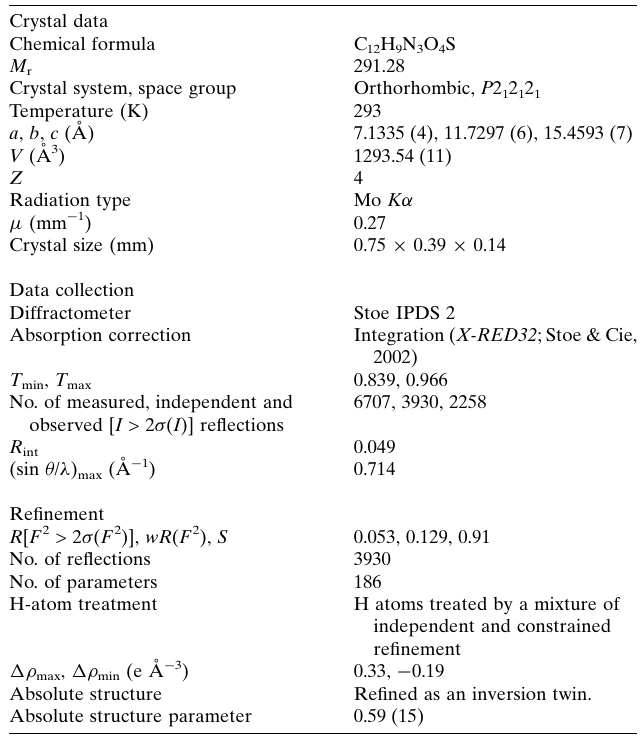
Table 3 Experimental details. Crystal data Chemical